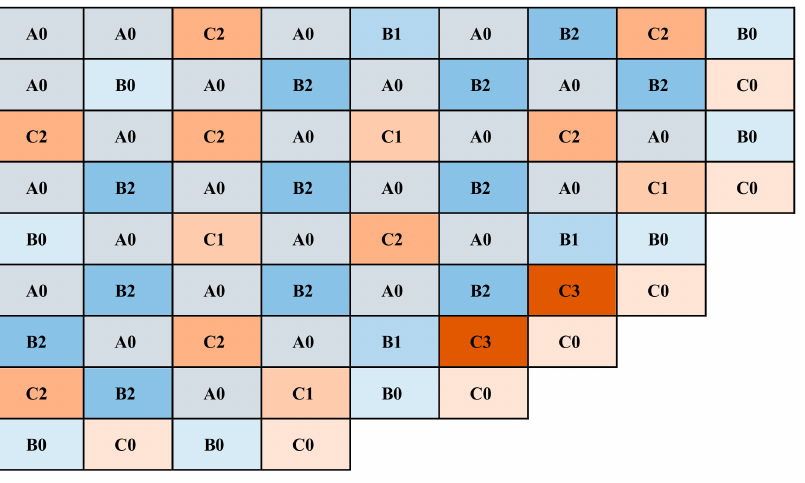
Figure 3. First cycle fuel loading pattern.